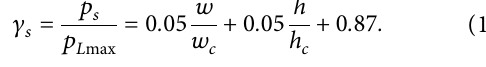
Figure 4: Peak pressure longitudinal